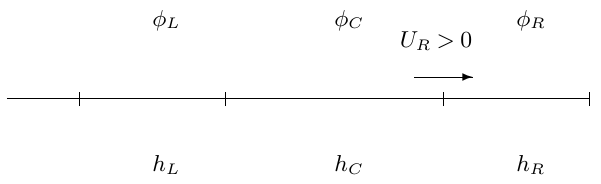
Figure 2. Stencil for third-order approximation. Fig. 2. Cut cell with face and volume area information (left) and arrangement of face and cell centered momentum (right). Fig. 3. Stencil for third-order approximation.